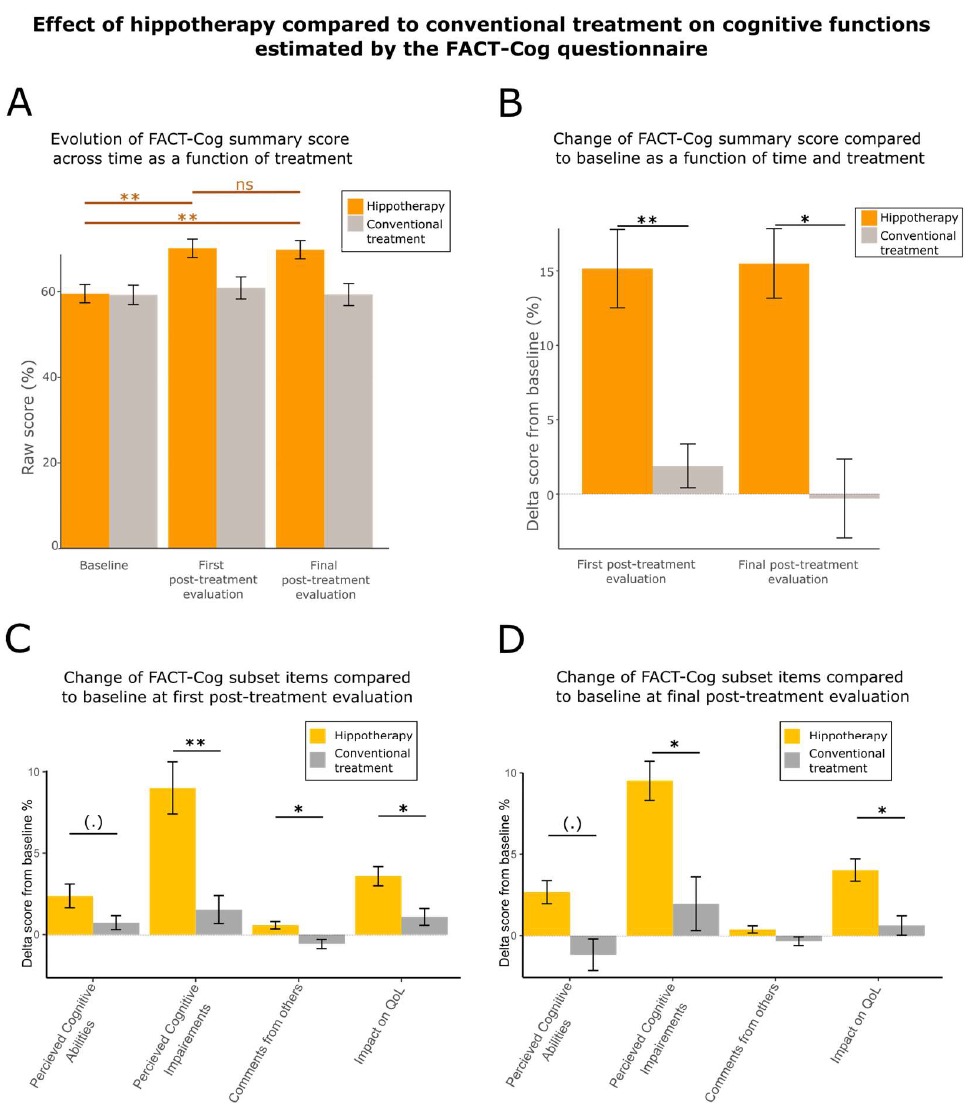
Figure 3. Effects of hippotherapy treatment compared to conventional treatment on cognitive func- tions, as estimated by the FACT-Cog questionnaire. ( A ) Bar chart represents means (M) and standard errors of means (SEM) for the evolution of FACT-Cog summary scores across time as a function of treatment’s type. Values (M ± SD) are as follows: Baseline = 89.3 ± 25.7, First post-treatment evaluation = 105.0 ± 25.9, Final post-treatment evaluation = 105.0 ± 25.8 for the hippotherapy group; Baseline = 88.9 ± 27.4, First post-treatment evaluation = 91.3 ± 31.2, Final post-treatment evaluation = 89.0 ± 30.9 for the control group. ( B ) Change of score compared to FACT-Cog baseline score (M ± SEM), as a function of time and treatment. Values (M ± SD) are as follows: First post-treatment evaluation = 15.1 ± 21.1, Final post-treatment evaluation = 14.2 ± 18.8 for the hippotherapy group; First post-treatment evaluation = 1.89 ± 11.8, Final post-treatment evaluation = 0.582 ± 21.4 for the control group. ( C ) Comparison of score changes for the FACT-Cog subsets between the two groups at the first post-treatment evaluation. ( D ) Comparison of score changes for the FACT-Cog subsets between the two groups at the final post-treatment evaluation. (**) p < 0.01; (*) p < 0.05; (.) close to significance (between 0.08 and 0.05); (ns)